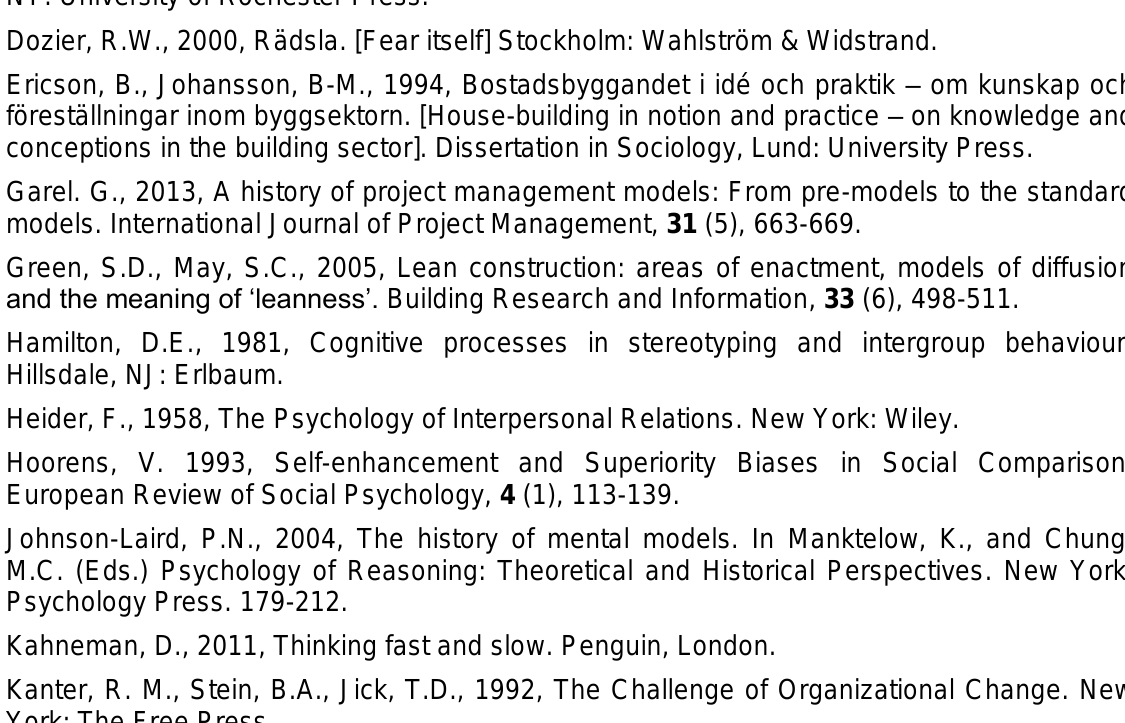
Sunding, L and Ekholm A (2014) ‘Problems and problem attention in the construction sector – understanding the influence of human factors’ , Australasian Journal of Construction Economics and Building, 14 (2)